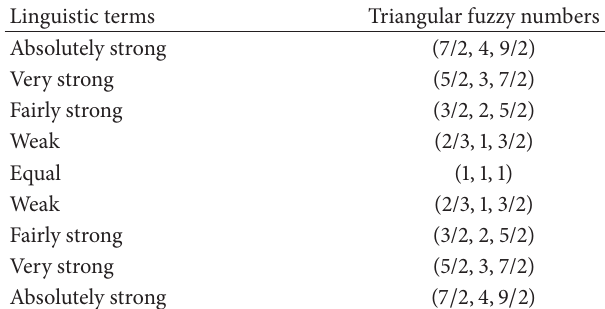
Table 2: Triangular fuzzy number of linguistic